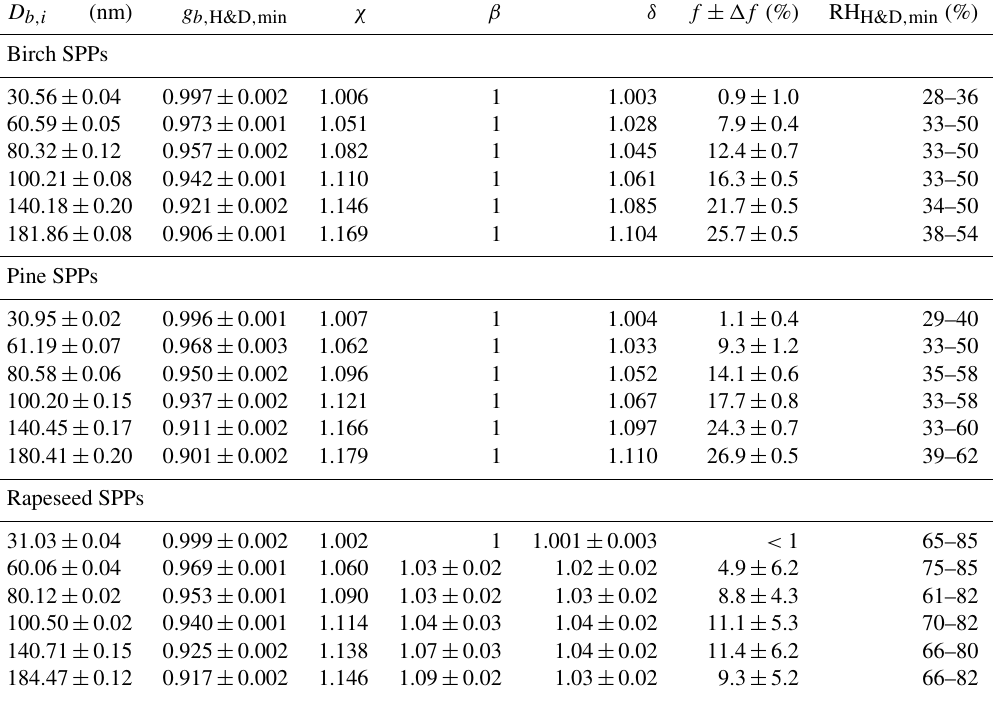
Table 2. The size-dependent microstructural rearrangement parameters of subpollen particles (SPPs) obtained in the H&D experiment. D b,i and g b, H&D , min are mean ( ± 2SD) initial mobility diameter and minimum mobility growth factor, respectively. The dynamic shape factor ( χ ), porosity ( δ ), and void fraction ( f ) together with propagated error ( (cid:49)f ) are calculated from Eqs. (3), (4), and (5), respectively. For birch, pine, and ∼ 30nm rapeseed SPPs, the particle shape envelope ( β ) is set to 1; for rapeseed SPPs at D b,i > 30nm, the β values were obtained as described in Supplement Sect. S8. RH b, H&D , min is the relative humidity at which the minimum mobility growth factors were observed. D